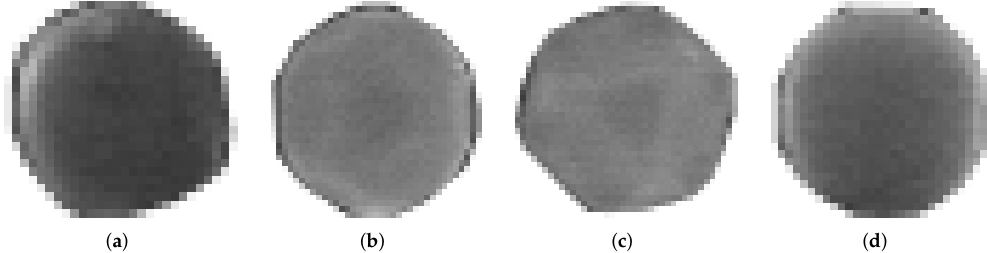
Figure 3. Manually segmented images of Ag quasi-spheres used as templates to generate new images. These four templates, taken from the micrograph in Figure 2 are part of a set of images used in the fourth pattern in this work: ( a ) Template #1 of an Ag quasi-sphere; ( b ) Template #2 of an Ag